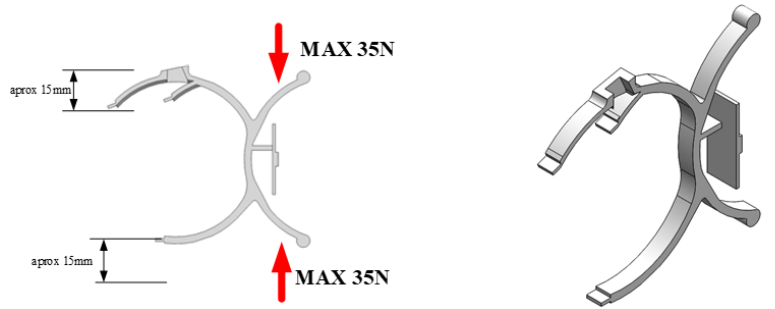
Figure 1. General view of mechanism.